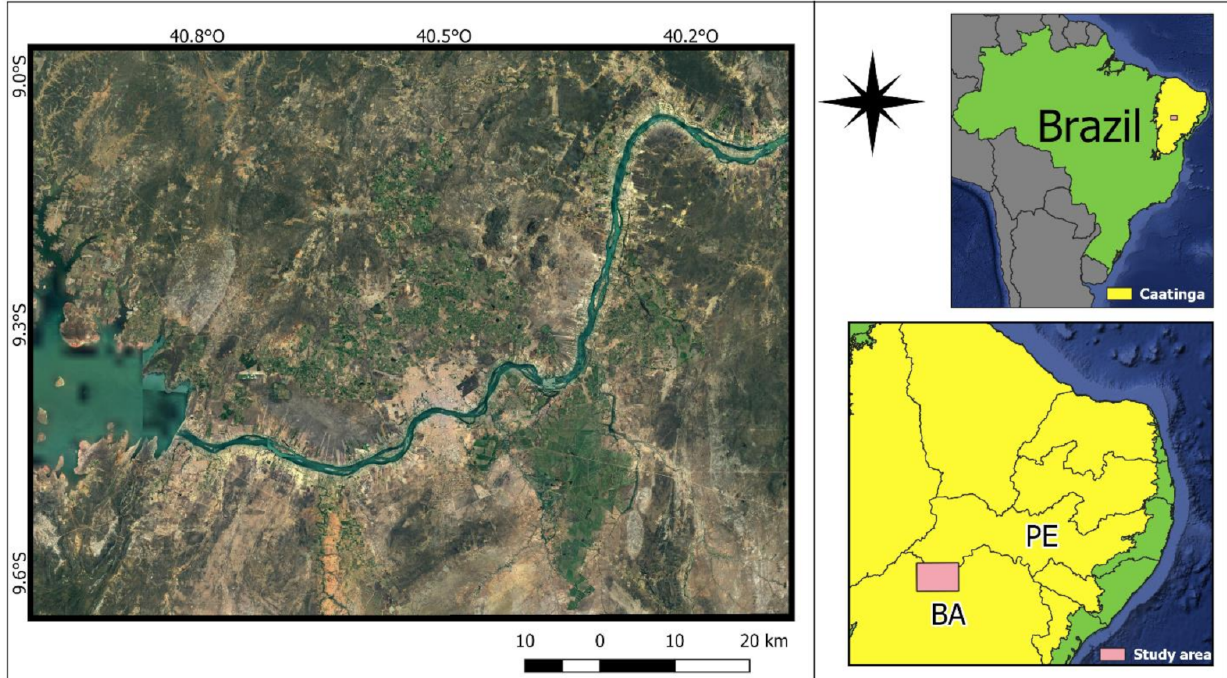
Figure 1. Study area within the Caatinga biome, in Northeast Brazil (BA: Bahia state, PE: Pernambuco state). The pink rectangle represents the whole study